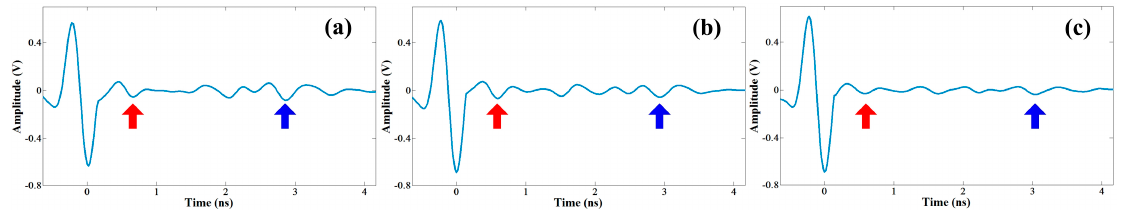
Figure 18. The field cores of asphalt surface layer from the test loop in ( a ) STR7; ( b ) STR8; ( c ) STR9.